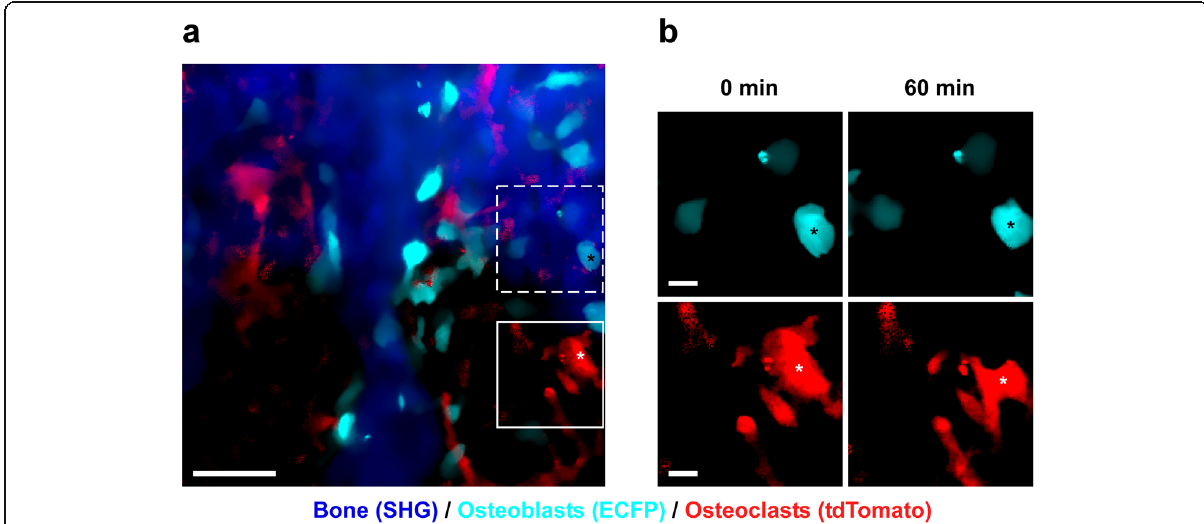
Fig. 1 Intravital two-photon microscopy images of calvarial bone in Col2.3-ECFP/TRAP tdTomato mice. a Representative image of the bone cavity at calvarial bone. Cyan, osteoblasts expressing Col2.3-ECFP; red, osteoclasts expressing TRAP tdTomato; blue, bone tissues (second harmonic generation, SHG). Scale bar, 50 μ m. b Magnified images of osteoblasts (region delineated by dotted lines in a ) and osteoclasts (region outlined in a ) captured at an interval of 60 min. Although the osteoblasts underwent very few morphological changes, the osteoclasts underwent dramatical changes in morphology. Scale bar, 10 μ